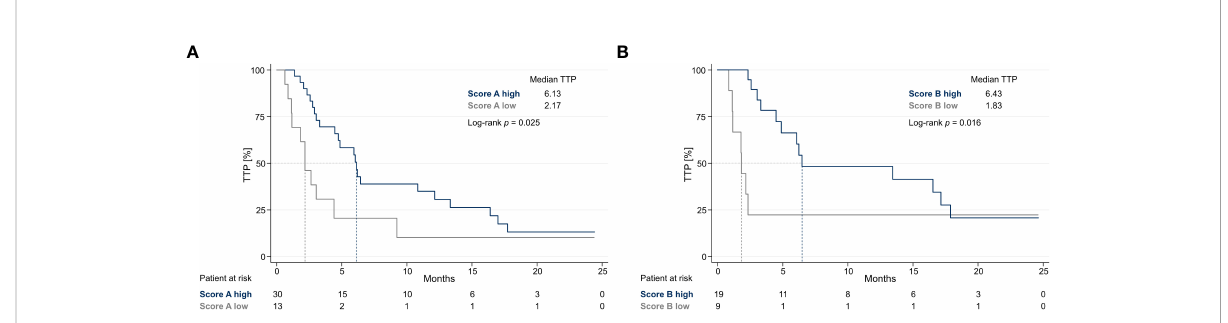
FIGURE 3 Kaplan – Meier curves of TTP for Scores A and B (A) Kaplan – Meier curves show TTP of patients with high ( ≥ 14.78) vs . low Score A values (<14.78). (B) Kaplan – Meier curves show TTP of patients with high ( ≥ 0.01782) vs . low Score B values (<0.01782). Score A = Tregs ÷ (CD4 + /CD8 +